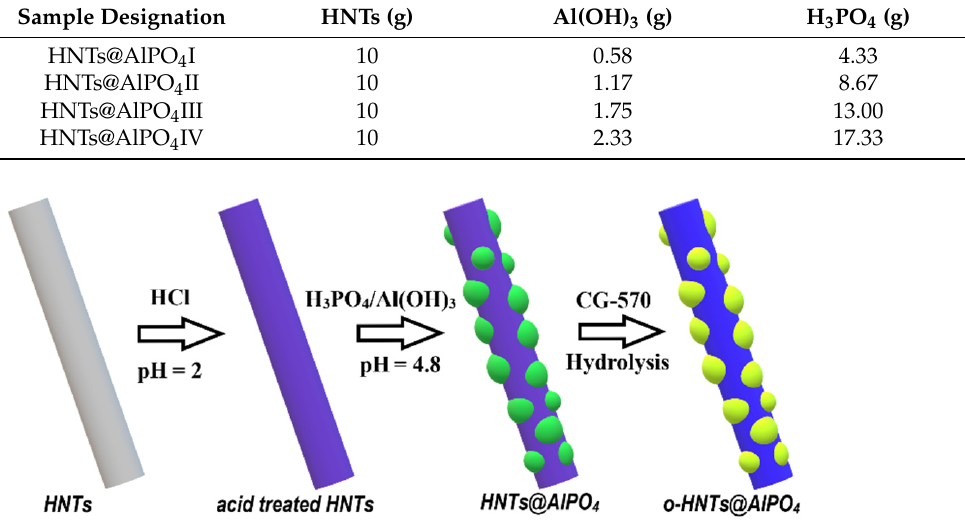
Figure 1. A schematic diagram of the preparation and modification of HNT S @AlPO 4 .